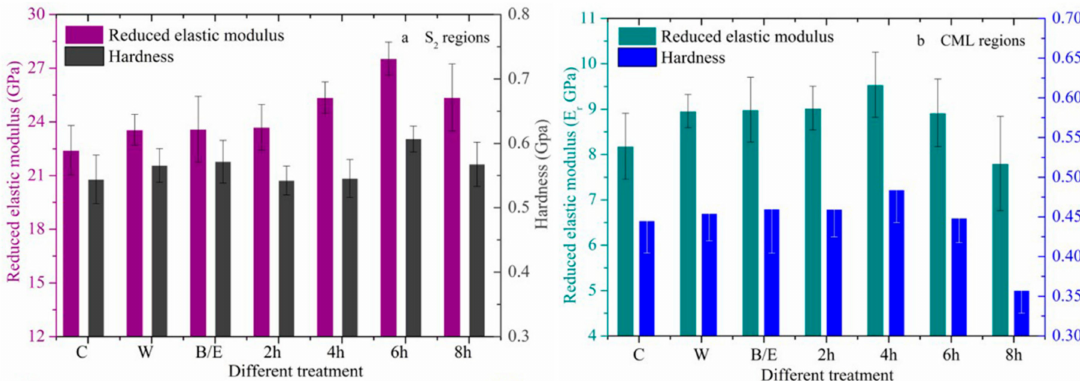
Figure 4. Changes in the mechanical properties of cell walls with acid gradient treatment. (( a ): S 2 regions; ( b ): CML regions).